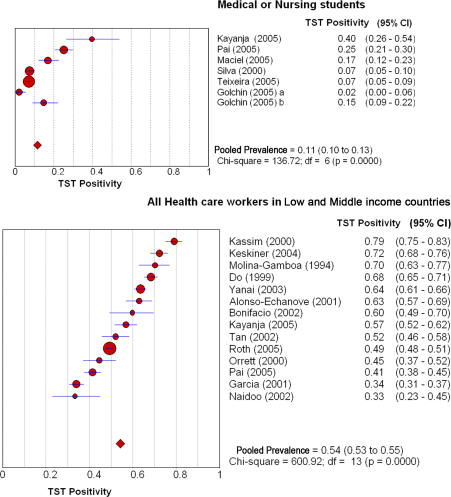
Prevalence of TB Infection in HCWs as Determined by TST SurveysThe circles and the lines represent the point estimates and 95% CIs, respectively. The size of the circle indicates the study size, and the diamond indicates the pooled estimate (weighted average) and its 95% CI. The heterogeneity chi-square statistics are 142.6 (p < 0.01) for the medical students and 600.9 (p < 0.01), for all HCWs, indicating significant heterogeneity across studies. (a) Indicates estimate of TST positivity in nursing students at entry into nursing school. (b) Indicates estimate of TST positivity after 3 y in nursing school.